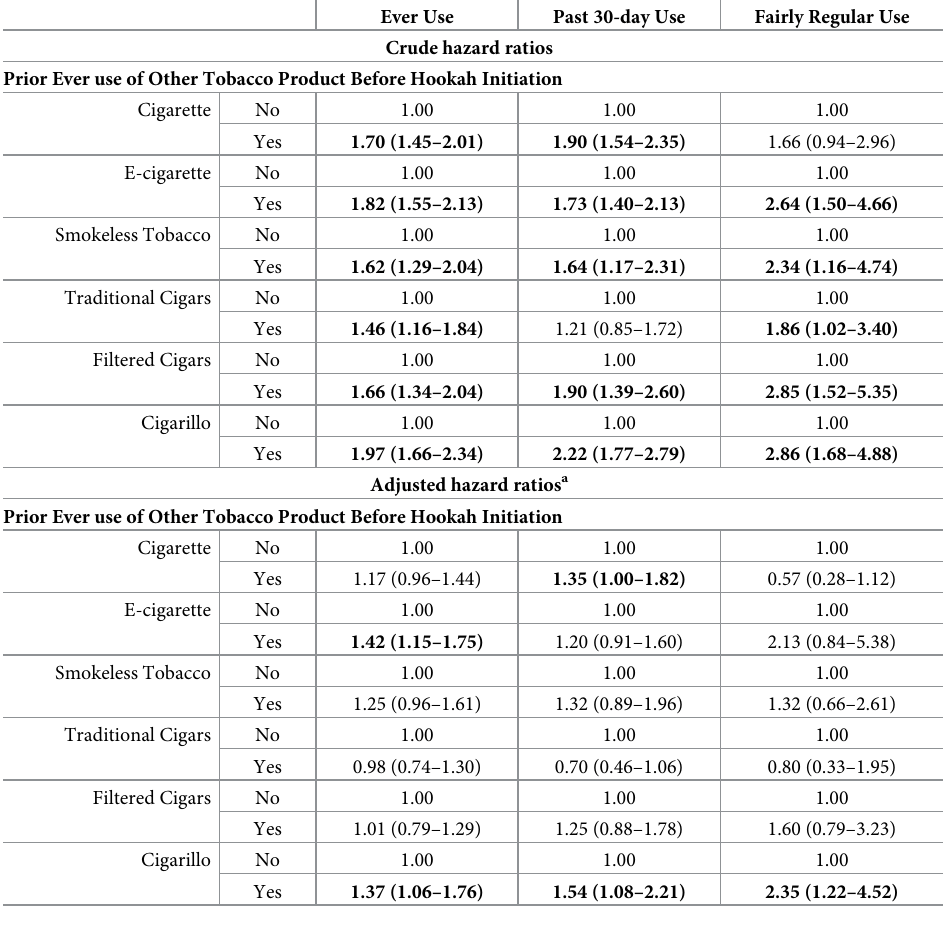
a : Hazard ratios (and 95% confidence intervals) are controlled for sex and